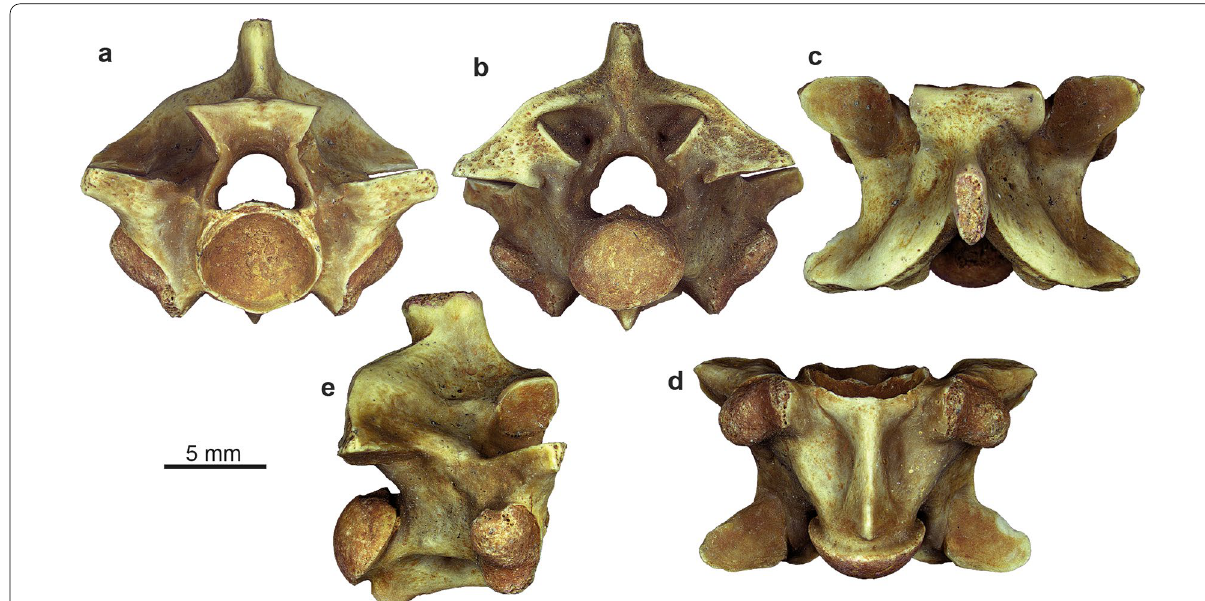
Fig. 80 Phosphoroboa filholii comb. nov. from an imprecisely known locality in the Phosphorites du Quercy: anterior mid-trunk vertebra (NHMW 2019/0033/0050) in anterior ( a ), posterior ( b ), dorsal ( c ), ventral ( d ), and right lateral ( e ) views